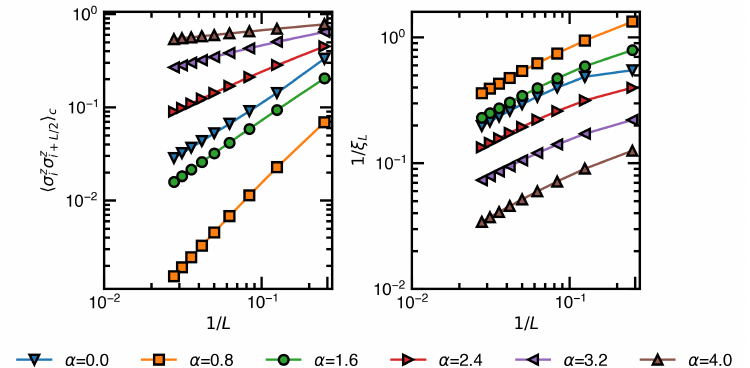
Figure 5: (Left) Connected correlation function against 1 / L . The seemingly alge- braic decay suggests the the cluster decomposition requirement is fulfilled for the considered α . These are chosen representatives of the critical phase. (Right) Inverse correlation length for different values of α in the critical phase. For both plots, we considered chains of lengths 4 ≤ L ≤ 36. To avoid odd / even effects, we present only L multiples of